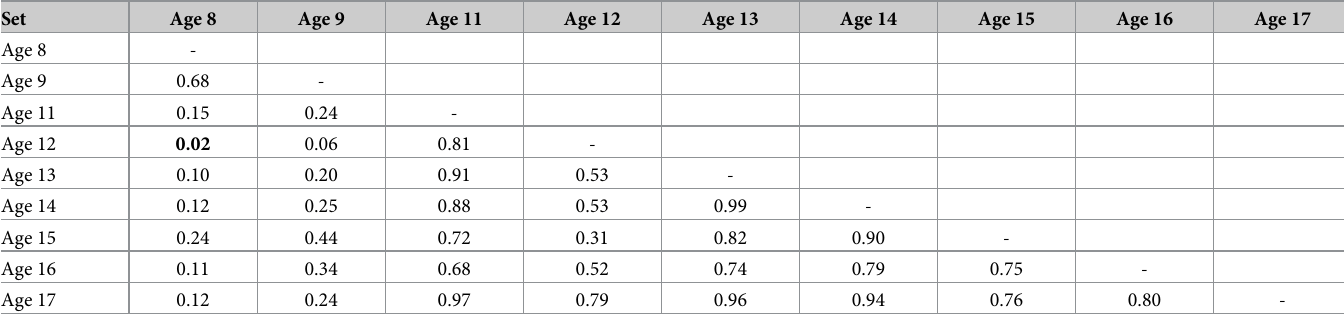
Note. One-way permutational multivariate analysis of variance test, Permutation N = 9,999, P (same) = 0.5996. Significantly p values ( < 0.05) are highlighted in bold.